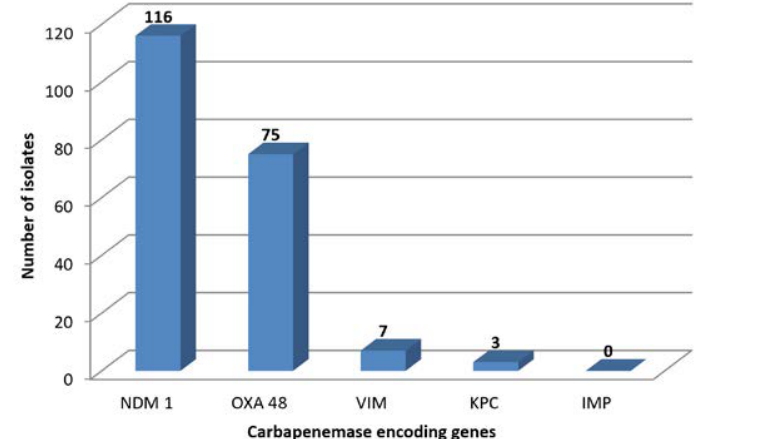
Fig. 1 . Distribution of Carbapenemase encoded genes in CRE